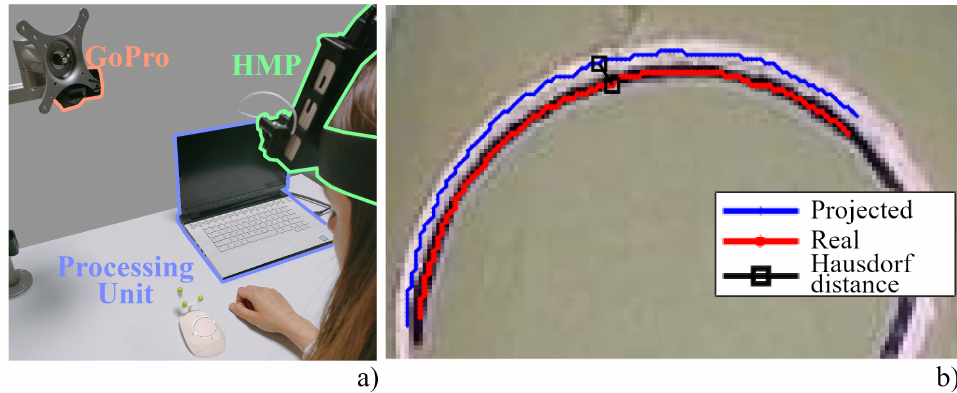
Figure 2. User test. ( a ) Set-up for the user test consisting of the Head-mounted Projector (green), the GoPro Hero 5 (orange), and the processing unit (blue). ( b ) Hausdorff distance between the projected center line (blue) and the real one (red). Points resulting from the Hausdorff algorithm are marked in black and the line connecting them is the Hausdorff distance between the two curves.